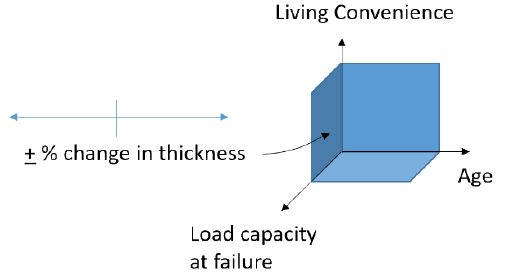
Figure 10. Three-dimensional representation of the effects of varying shell wall thickness on living convenience and load capacity, and natural addition of material on shell